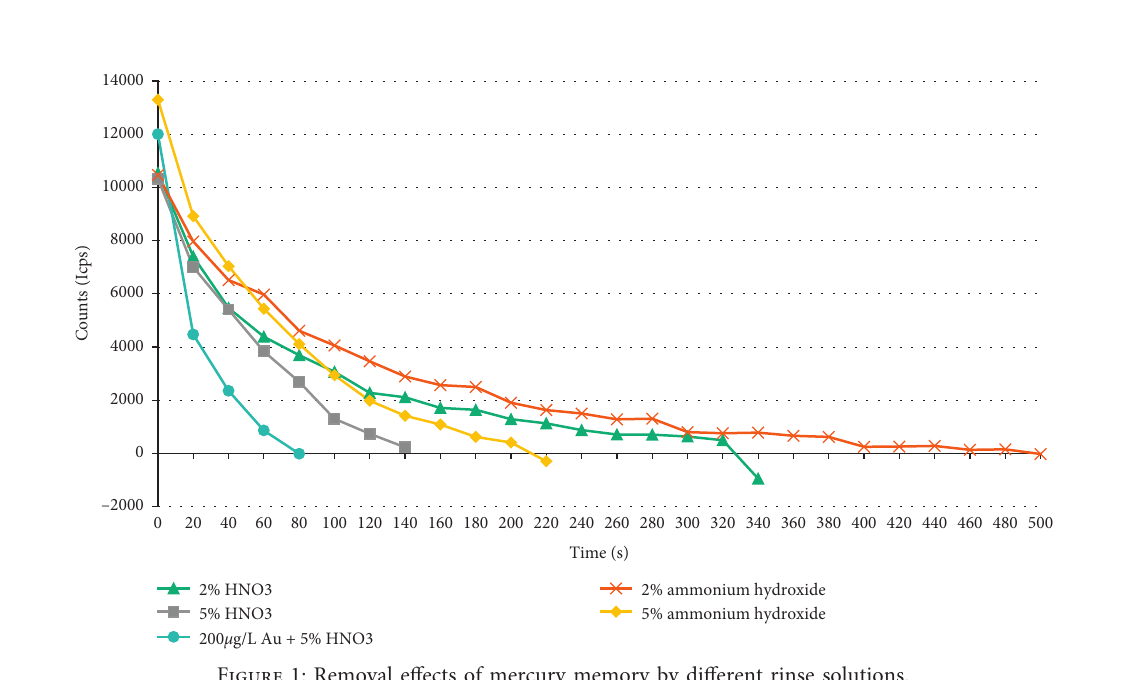
Figure 1: Removal effects of mercury memory by different rinse solutions.